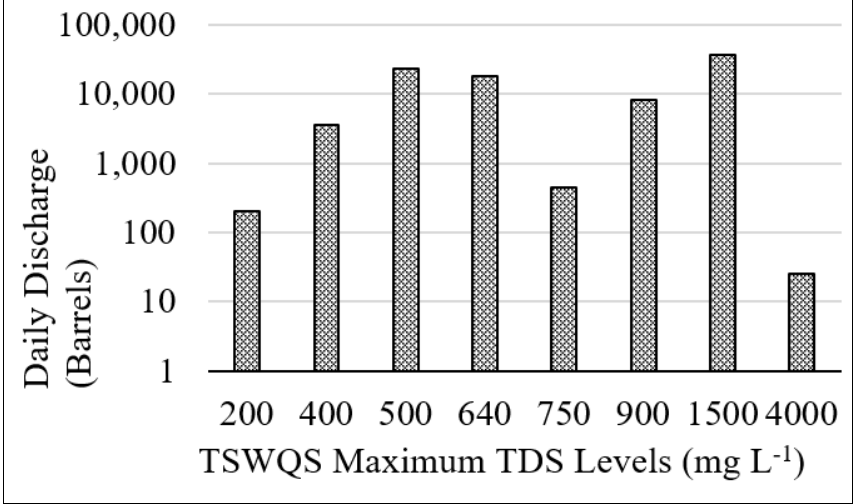
Figure 3. Permitted volumes of water discharged into various segments, as shown in Supplementary Information III by maximum allowable total dissolved solids